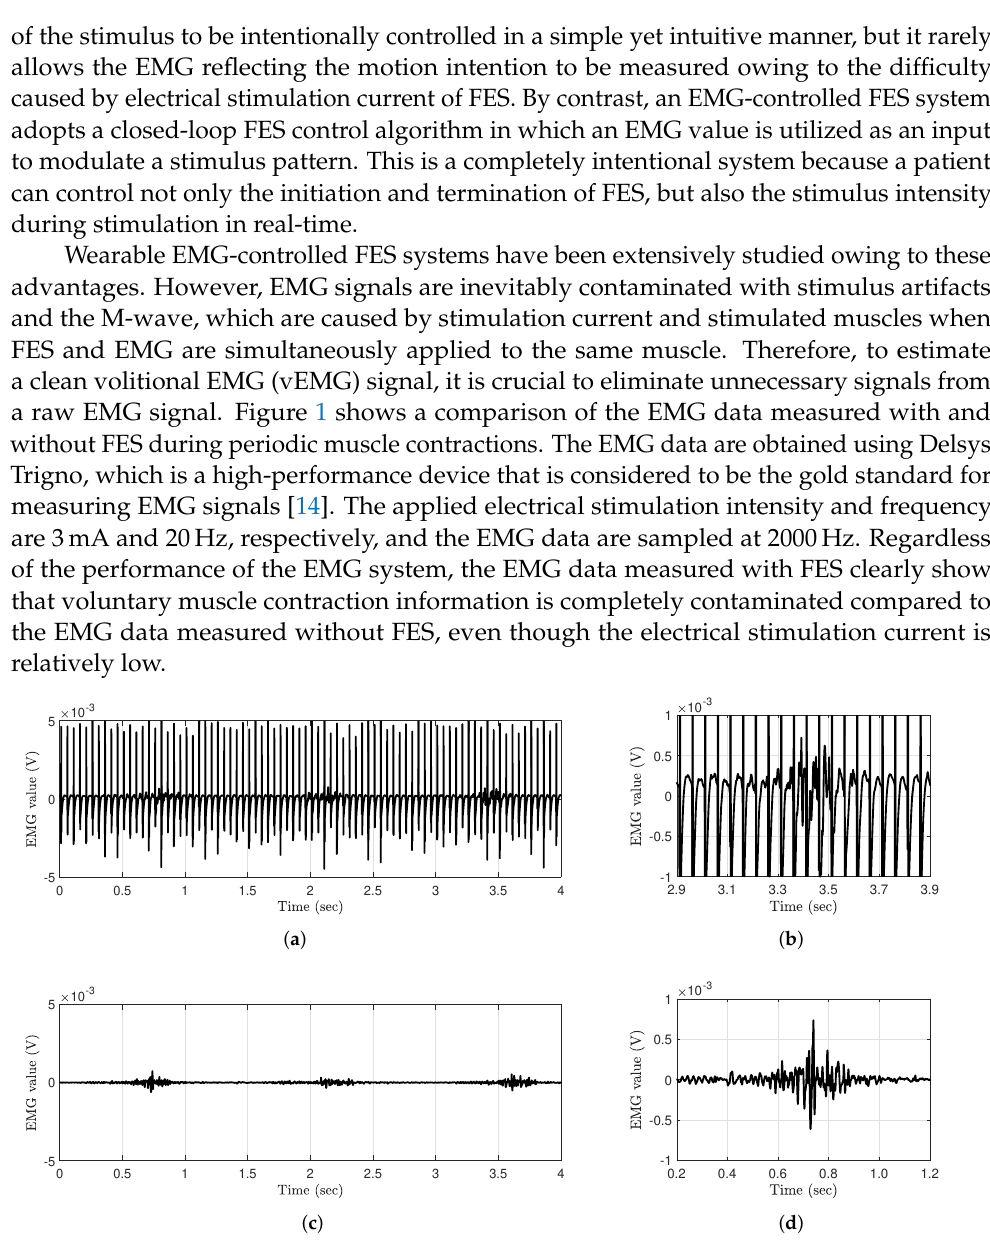
Figure 1. Comparison of raw EMG signals where the muscle is voluntarily and periodically con- tracted with and without FES. ( a ) Raw EMG signal with FES. ( b ) Raw EMG signal with FES (magni- fied). ( c ) Raw EMG signal without FES. ( d ) Raw EMG signal without FES